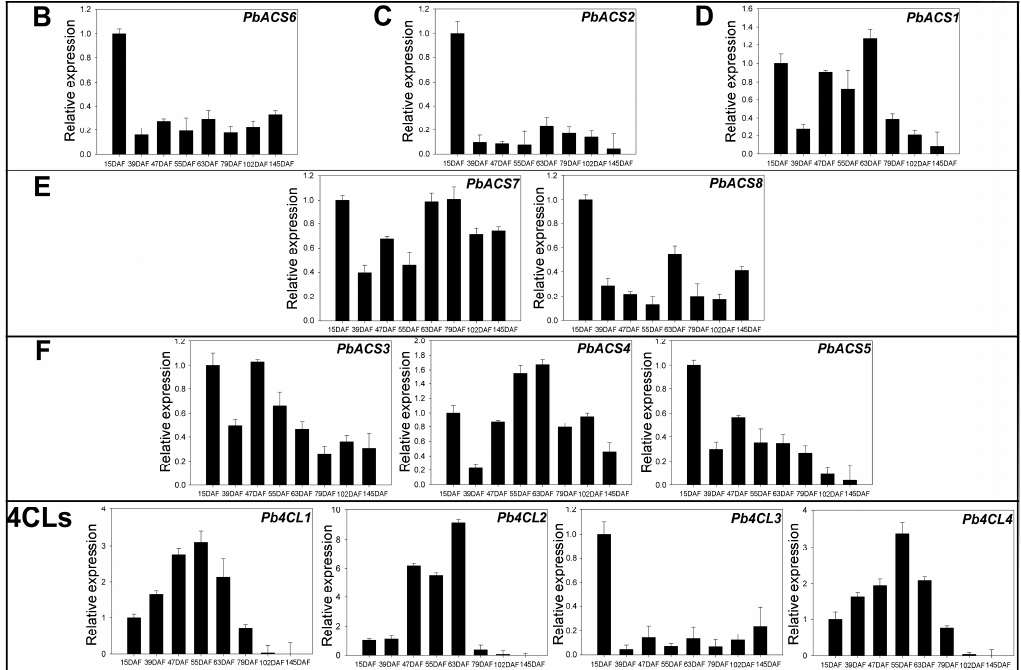
Figure 6. Expression levels of Pb4CL/PbACS genes during the eight stages of pear fruit development at 15 days after flowering (DAF), 39 DAF, 47 DAF, 55 DAF, 63 DAF, 79 DAF, 102 DAF and 145 DAF. These expression patterns were obtained using qRT ‐ PCR, and the relative expression was log2 transformed. B: clade B genes; C: clade C genes; D: clade D genes; E: clade E genes; F: clade F genes; and 4CLs: 4CL genes. Clades are defined in Figure 1.